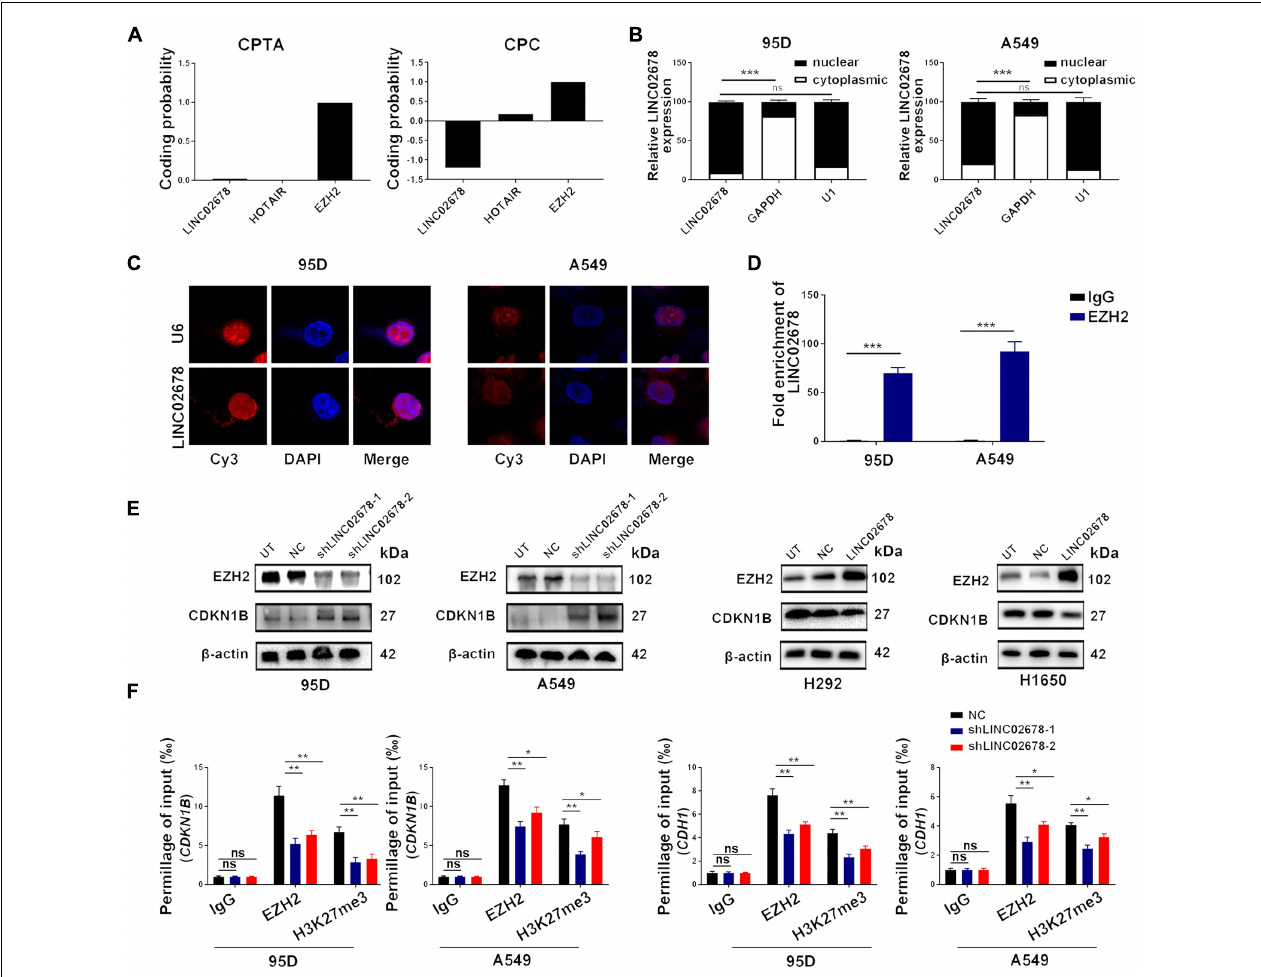
FIGURE 5 | LINC02678 is a nuclear-localized transcript and knockdown of LINC02678 represses EZH2 expression and activity. (A) Protein-coding potential of LINC02678 analyzed through the CPAT database and the CPC database. (B) RT-qPCR analysis of the relative RNA expression levels after nuclear and cytoplasmic RNA separation. GAPDH was used as a cytoplasmic marker and U1 was used as a nuclear marker. (C) Representative FISH images of the subcellular location of LINC02678 in 95D and A549 cells (red). Nuclei were stained with DAPI (blue). U6 was used as a nuclear marker. (D) RIP and RT-qPCR analysis of endogenous EZH2 bound with LINC02678 in 95D and A549 cells. IgG was used as the control group. (E) Western blotting shows the protein expression of EZH2 and CDKN1B after knockdown or overexpression of LINC02678. (F) CHIP-qPCR analysis of EZH2 and H3K27me3 occupancy on the E-Cadherin (CDH1) and CDKN1B promoter region in A549 and 95D cells after transfected with NC, shLINCC02678-1 or shLINC02678-2. (* p < 0.05; ** p < 0.01; *** p < 0.001. Data were obtained from three independent